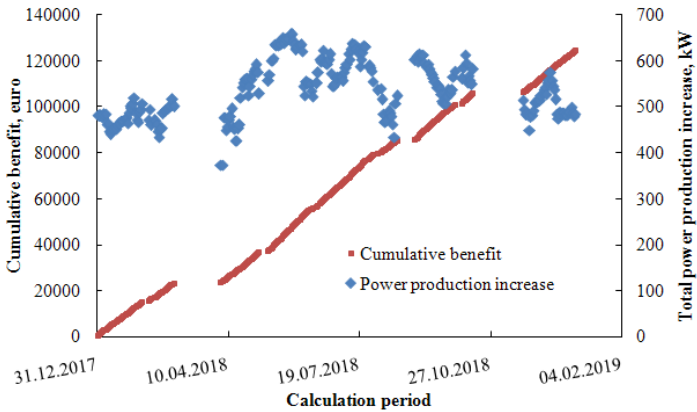
Figure 11. Cumulative benefit and the underlying total power production increase over one year calculation period for Case A—additional steam turbine installation.